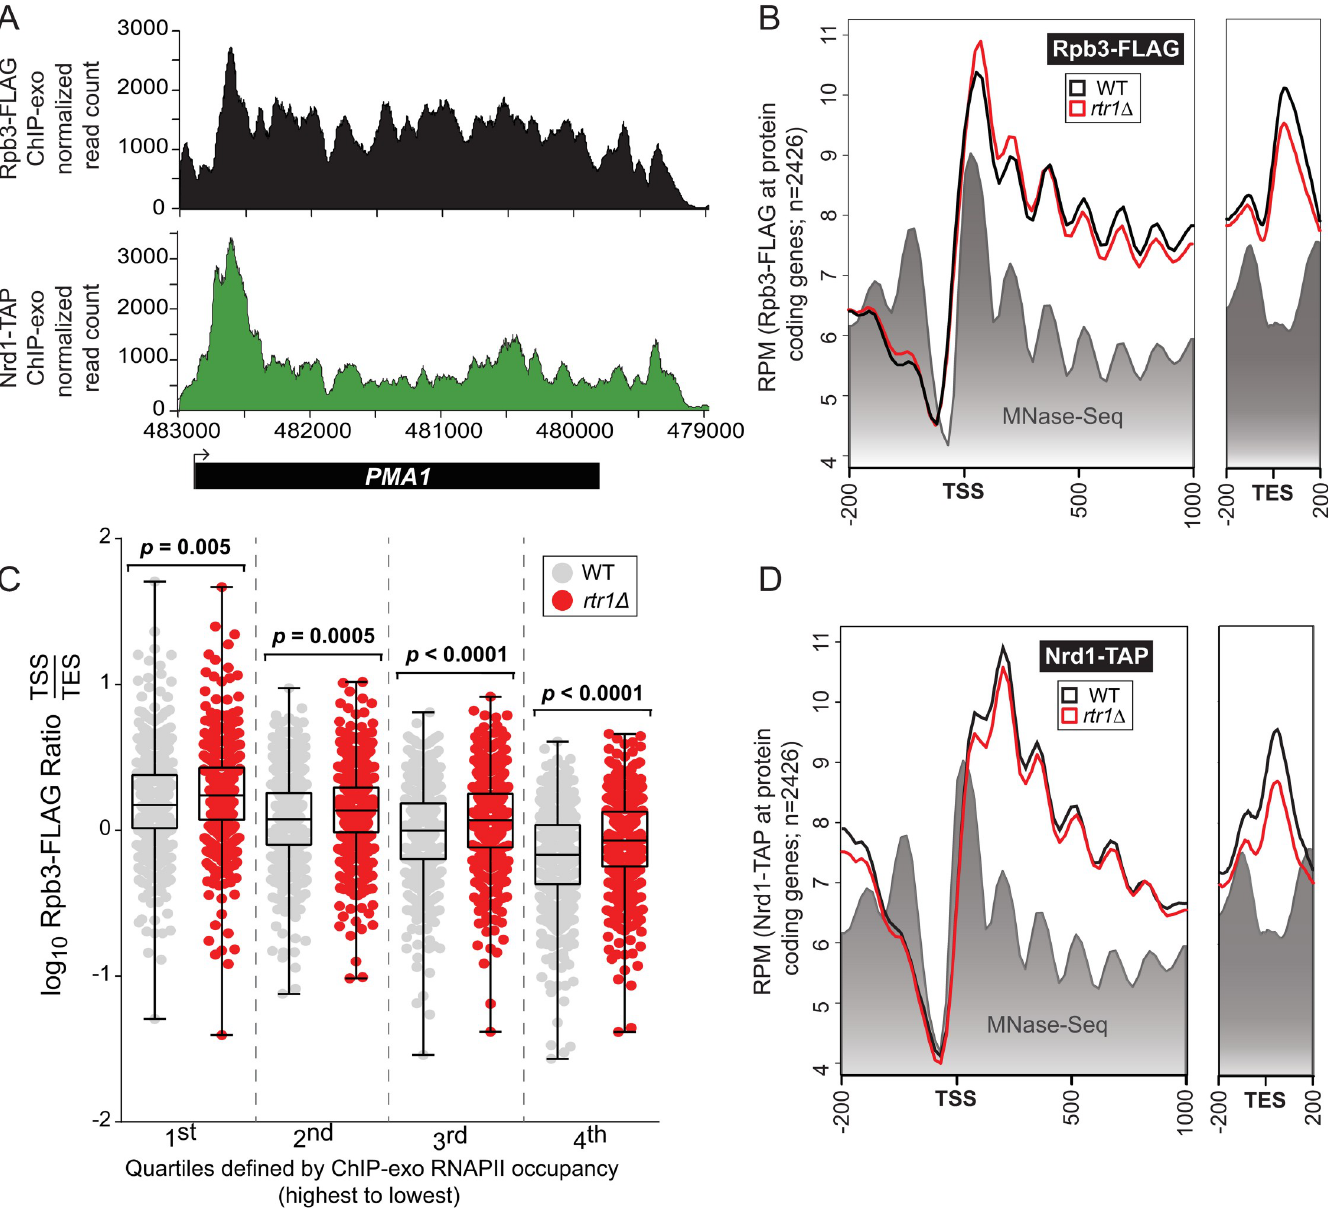
Fig 5. Deletion of RTR1 increases the ratio of RNAPII at the transcription start site relative to the transcription termination site. A) Normalized read count data for RNAPII (Rpb3-3XFLAG) and Nrd1-TAP at the PMA1 protein-coding gene. B) Average gene analysis of RNAPII (Rpb3) levels at 2,426 protein-coding genes -200 nucleotides upstream and +1000 downstream of the TSS and -200/+200 upstream/downstream of the annotated TES. The data is shown as average RPM values calculated using ngs.plot for each genotype designated by the colors in the legend. MNase-Seq analysis of total histones from WT cells is also shown as a reference for chromatin organization along the average gene. C) Average ratio of RNAPII occupancy at the TSS/TES for 2,426 protein coding genes. Statistical analysis of the ratios for WT and RTR1 deletion cells was determined by paired student’s t-test. D) Average gene analysis for Nrd1-TAP ChIP-exo as shown for panel